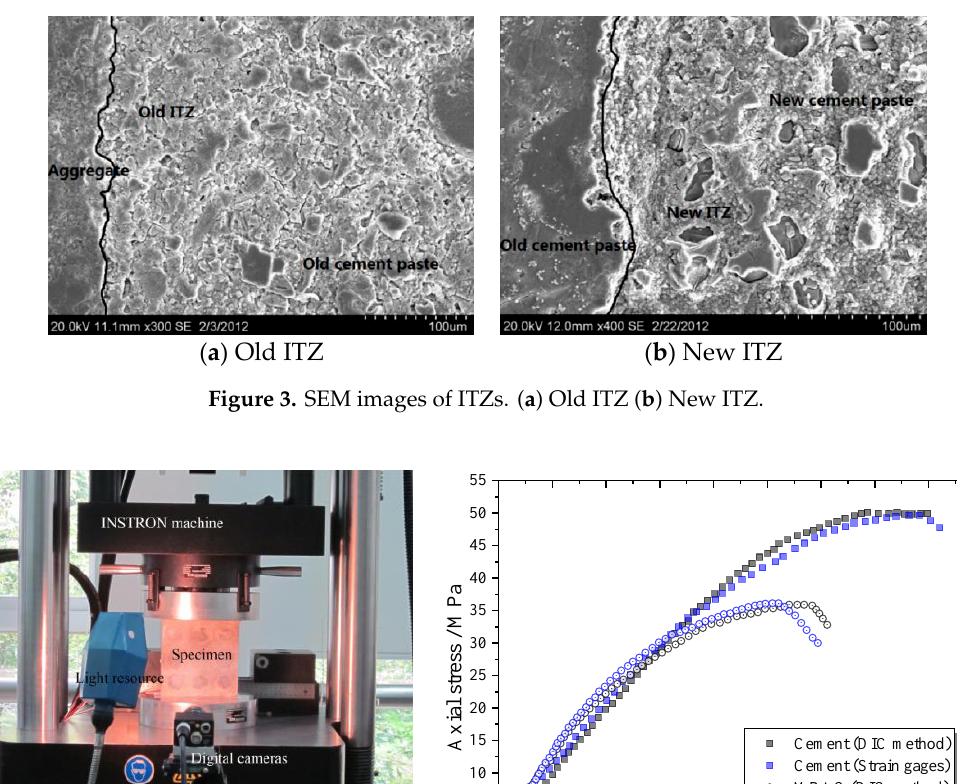
Figure 2. Nanomechanical properties of interfacial transition zones (ITZs). ( a ) Old ITZ ( b ) New ITZ